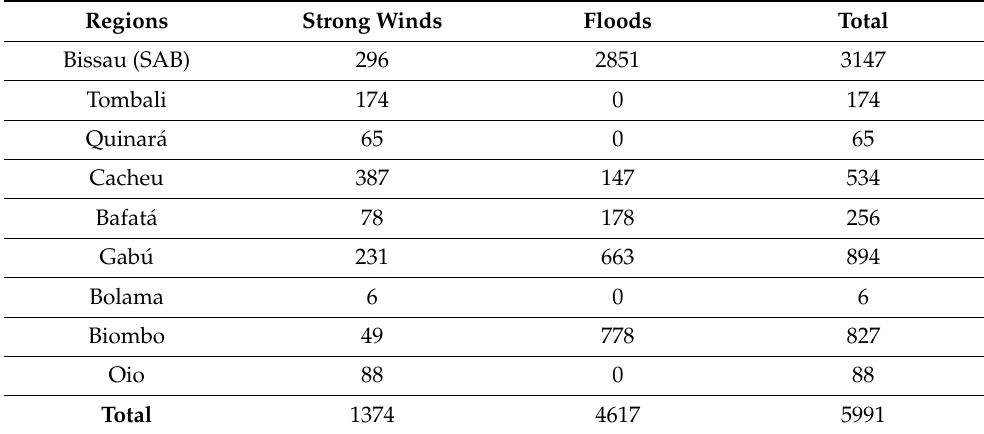
Table 2. Total number of displaced people by region caused by strong winds and flooding. Source: National Civil Protection Service, Guinea Bissau.